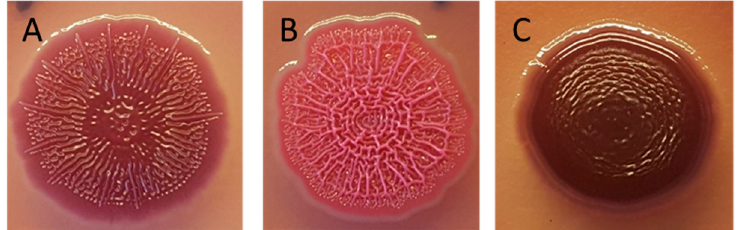
Figure 1. E. coli biofilm morphotypes on Congo Red (CR) agar. ( A ) Red, dry and rough (RDAR): indicating expression of curli fimbriae (curli) and cellulose in the biofilm matrix. ( B ) Pink, dry and rough (PDAR): indicating expression of cellulose, but not curli. ( C ) Brown, dry and rough (BDAR): indicating expression of curli, but not cellulose.